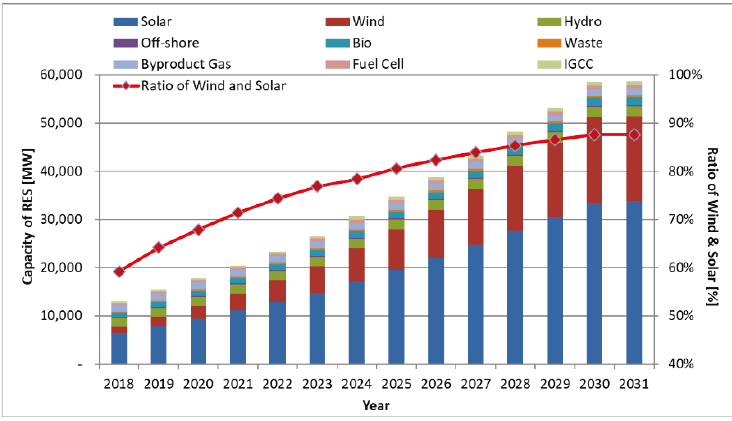
Figure 3. Capacity expansion plan for renewable energy sources (RES) in Korea.